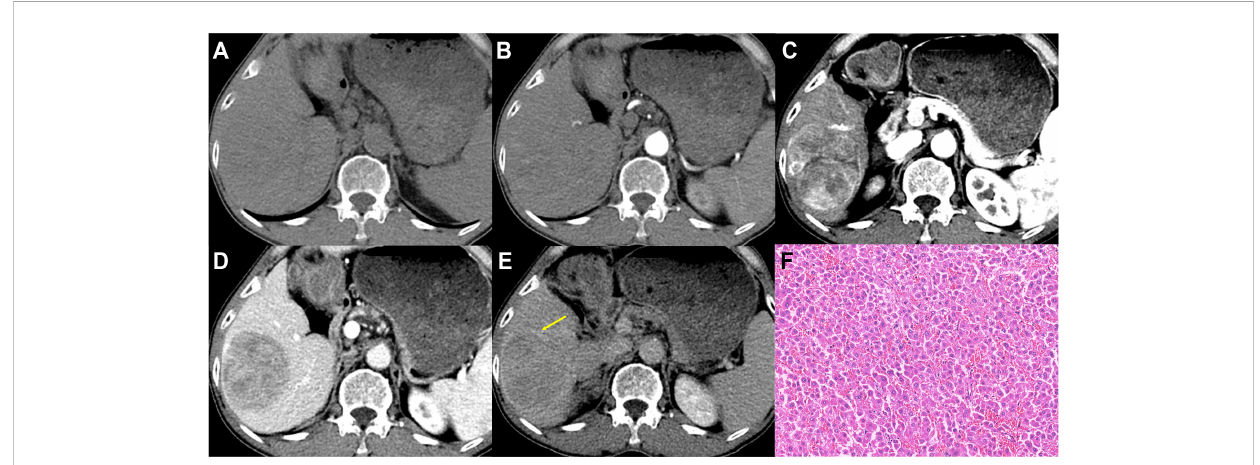
FIGURE 3 Imaging features and pathological information of a 62-year-old male non-MTM-HCC patient with an AFP level of 26.58 ng/mL and hemoglobin of 119 g/L. Multiphase axial contrast-enhanced CT (CECT) demonstrates iso-attenuation in the unenhanced phase (A) and early arterial phase (B) . Strong and heterogeneous hyperenhancement (APHE) and little intratumor hypoenhancement are evident in the late arterial phase (C) . Capsule enhancement (yellow arrow) and washout are demonstrated in the portal venous phase (D) and delay phase (E) . Histopathology con fi rmed the diagnosis of non-MTM-HCC ( F , original magni fi cation, × 100; hematoxylin-eosin